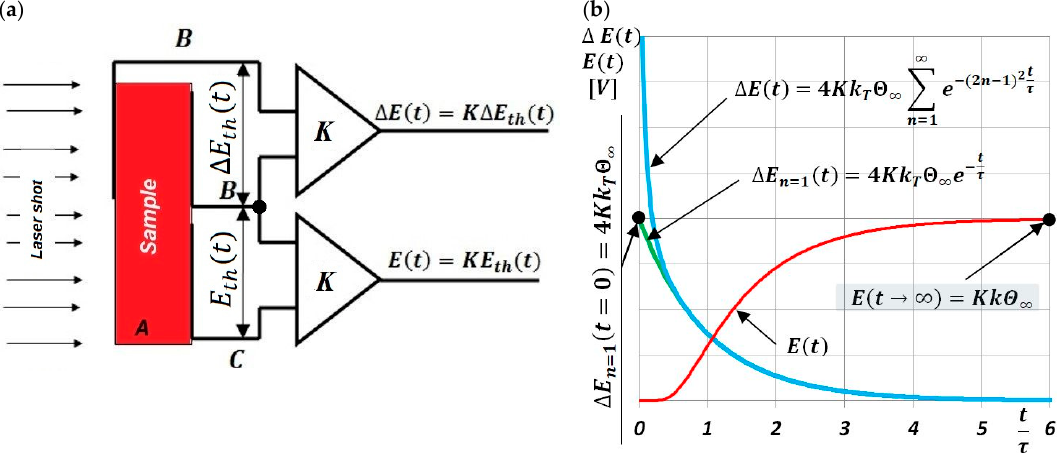
Figure 2. ( a ) Block diagram of system for the measurement of thermoelectric voltages ∆ E th ( t ) and